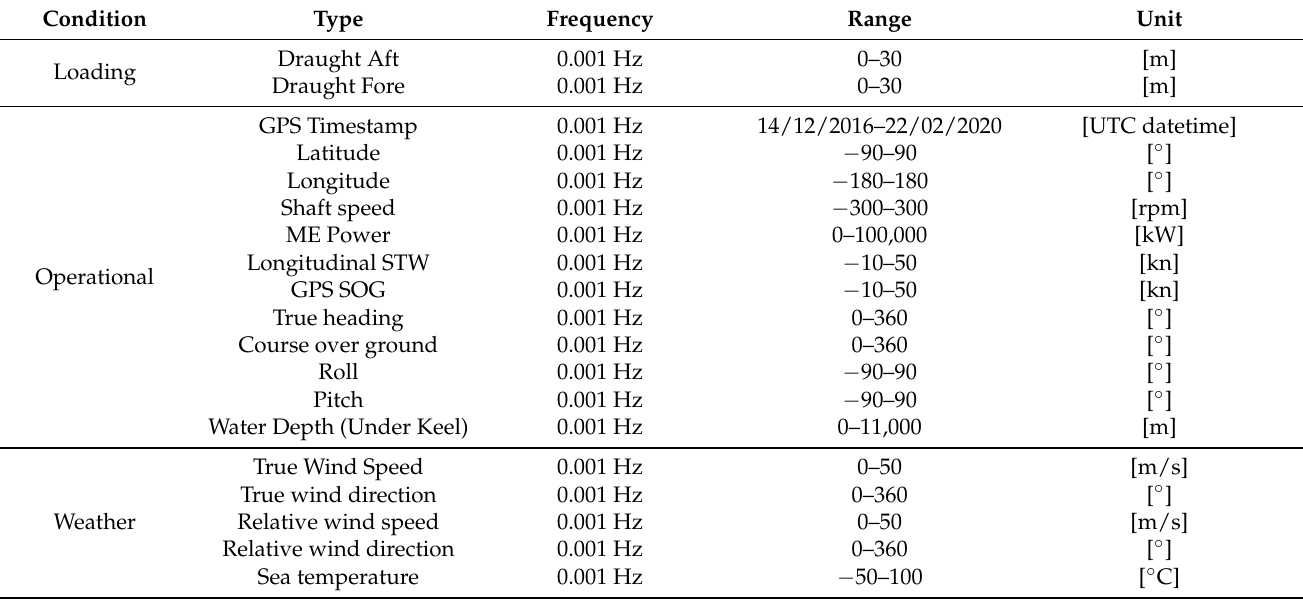
Table 2. Sampling frequency, acquisition range and units of CAMS data.